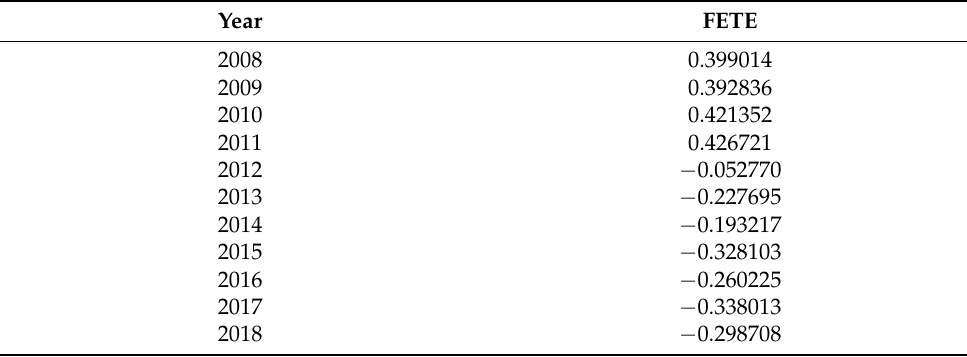
Table 8. Estimated time effects for the FETE